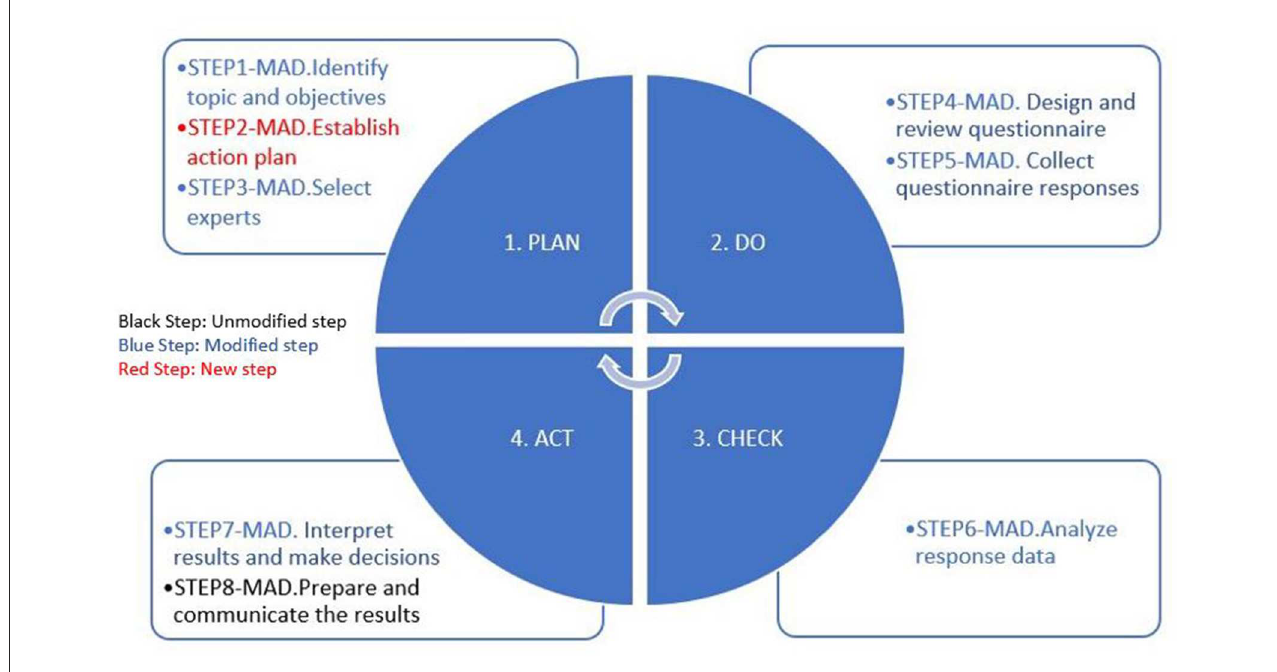
FIGURE2 Agile Delphi